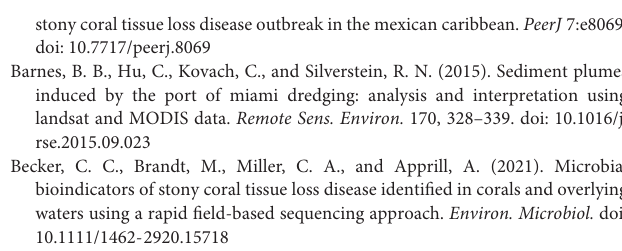
Supplementary Figure 2 | Micrographs of coral tissue stained with hematoxylin and eosin. Columns denote transmission treatments (from left to right): healthy sediment, disease contact, diseased sediment, and diseased sediment (acute). (A) Tissue from healthy sediment treatment: Symbiodiniaceae in vacuoles, some